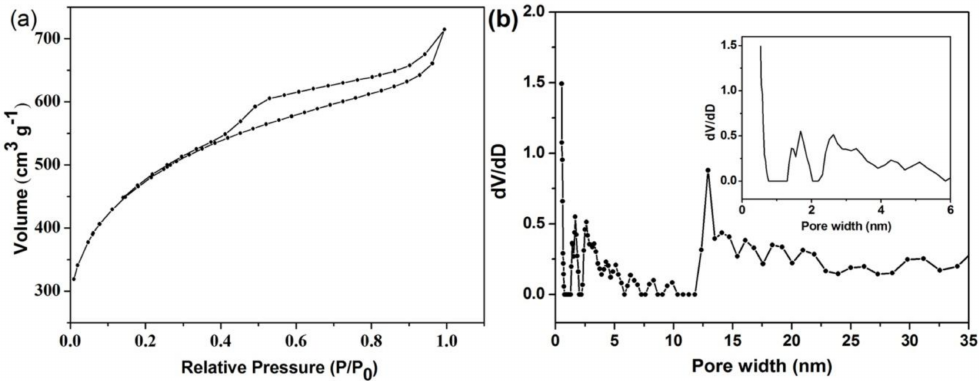
Figure 3. ( a ) The N 2 adsorption/desorption isotherm of SCF and ( b ) the corresponding pore size distribution calculated by the non-local density functional theory NLDFT model with the enlarged image in the inset.